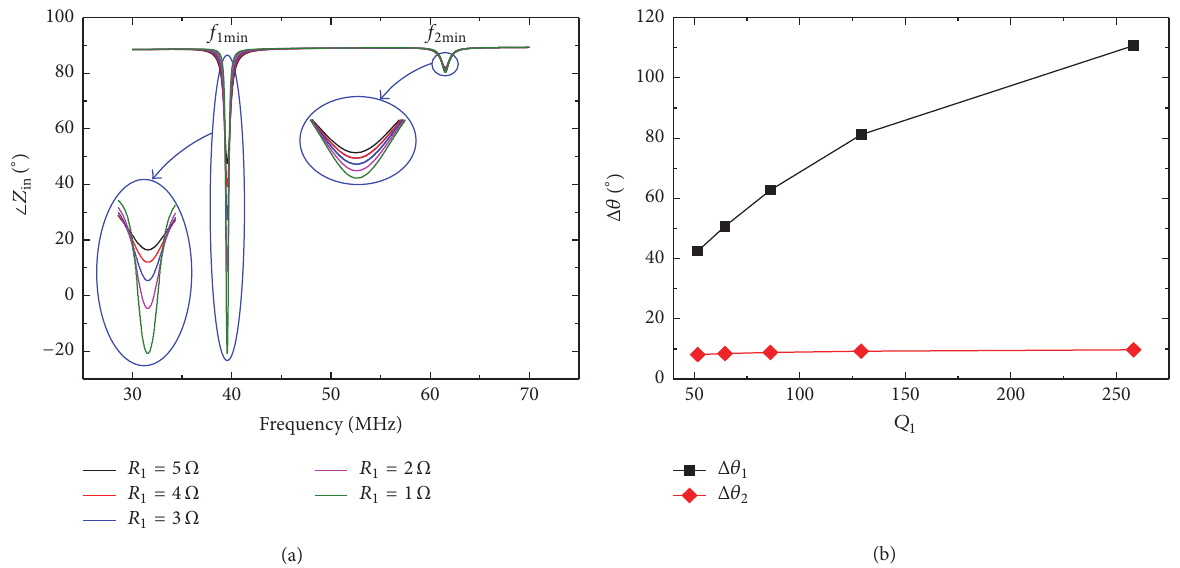
Figure 5: (a) Phase versus frequency curve of the readout coil when the 𝑄 factor 𝑄 1 increased and (b) the influence of 𝑄 1 on the value of Δ𝜃 1 and Δ𝜃 2 .